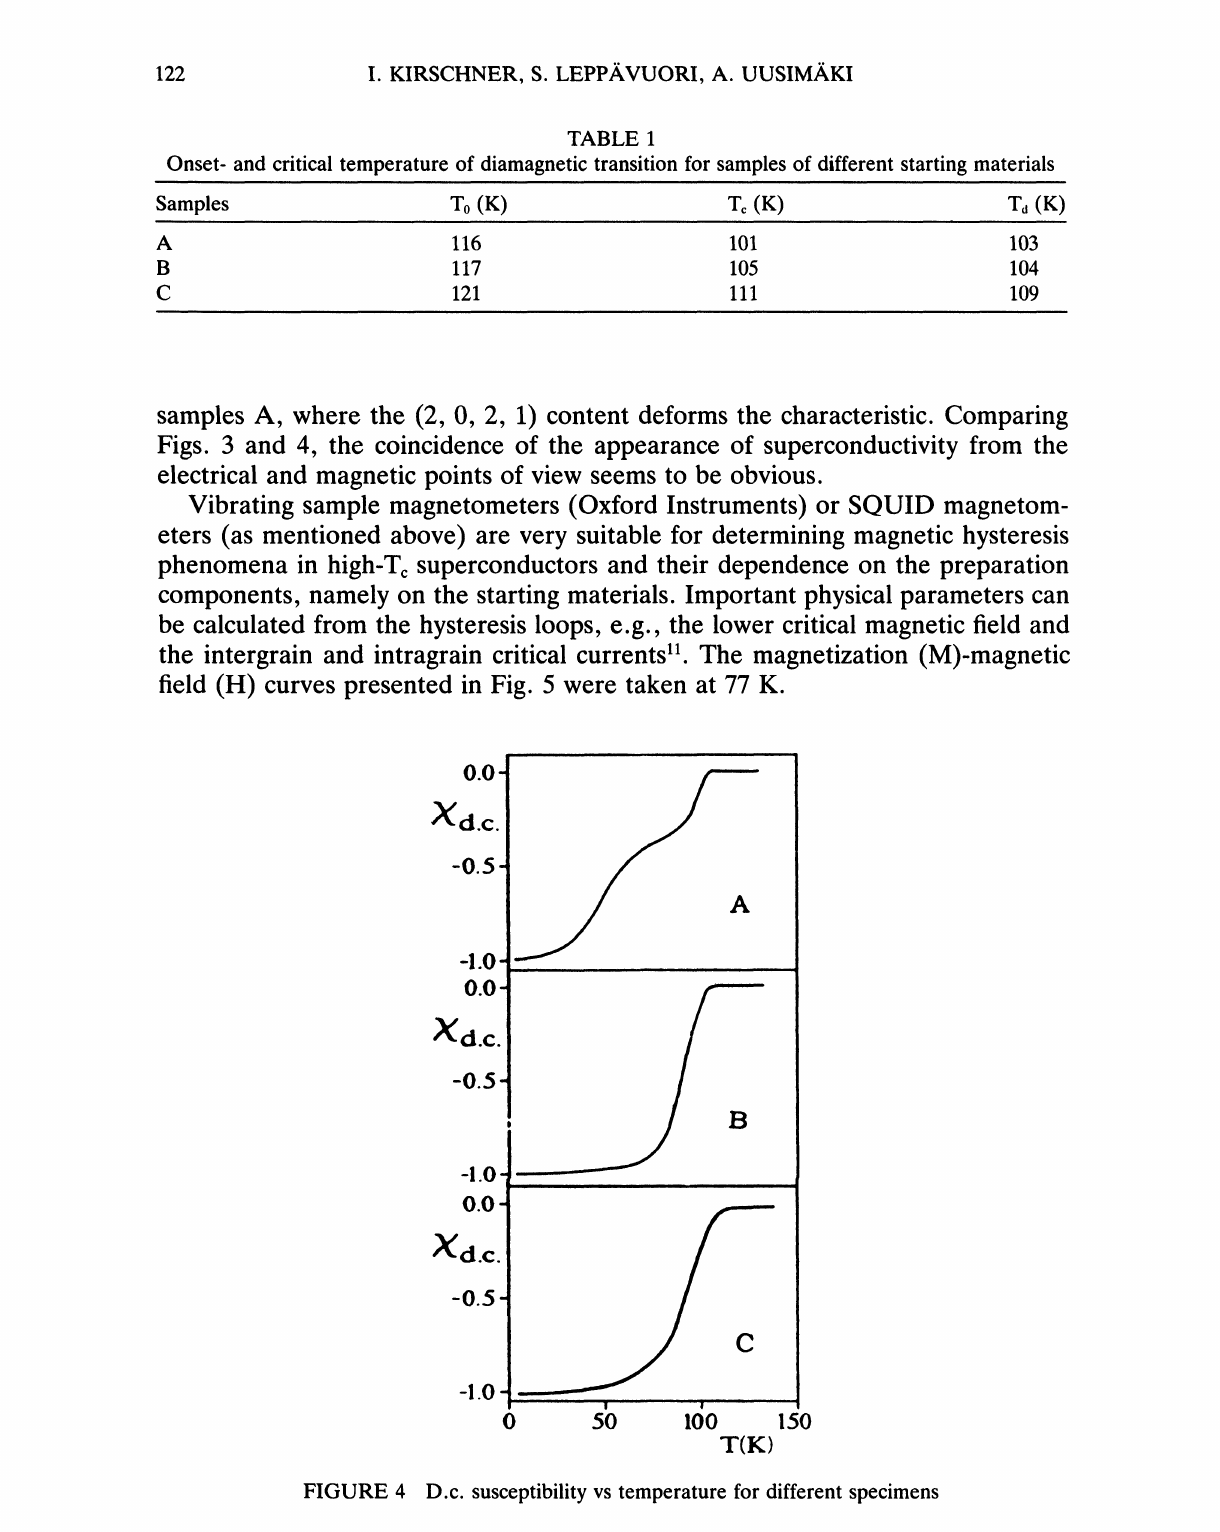
FIGURE 4 D.c. susceptibility vs temperature for different